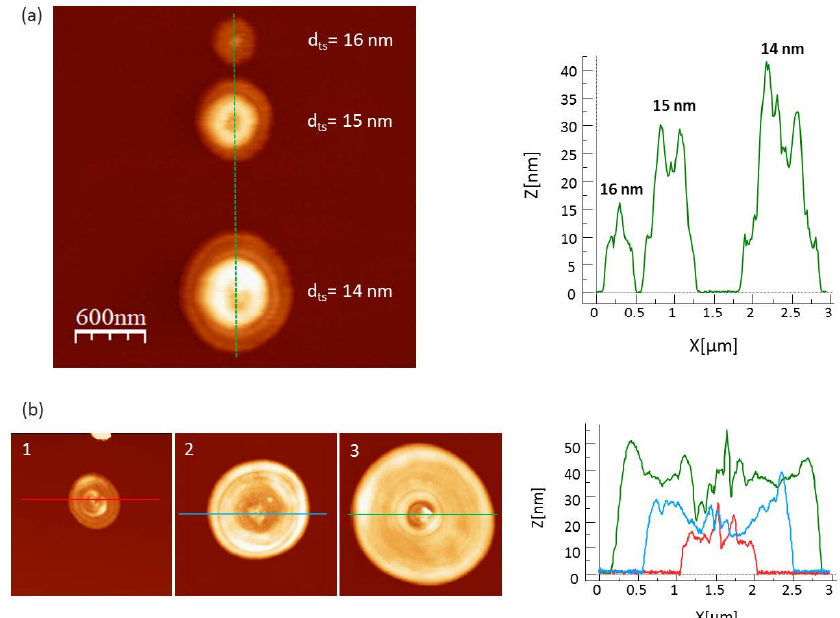
Figure 2. ( a ) AFM topography image of three oxide patterns performed at V ox = − 26 V, t ox = 40 ms and different tip ‐ sample distances, from top to down: 16 nm, 15 nm and 14 nm, respectively, and the corresponding height profiles of the oxide patterns; ( b ) Set of three topography images of 3 μ m × 3 μ m showing dots oxidized at − 21 V with an increasing pulse time of (1) 100 ms, (2) 200 ms, and (3) 300 ms, respectively, with their corresponding height profiles on the right side.